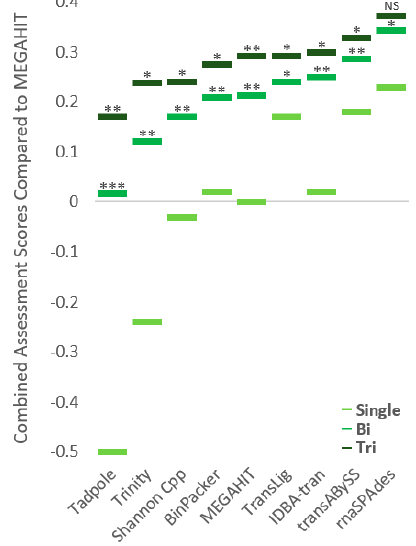
Figure 2. Single-, bi-, and tri-assembly assessment score averages. Average assessment scores from single-, bi-, and tri-assembly runs compared to MEGAHIT single-assembly as a baseline score (0). Scores lower than 0 underperformed when compared to MEGAHIT single-assembly, whereas, scores higher than 0 overperformed. Average assessment scores calculated by the average of HISAT2 overall alignment, BUSCO complete score, and TransRate n50 and n90 metrics averaged across all files processed. Assemblers utilized are included in the x-axis to denote both their average scores for single assembly and their average scores as part of a pair of two or three. Two tailed paired T-tests were conducted between single-assembly and bi-assembly, and between bi-assembly and tri-assembly. P-values are noted between single- and bi-assembly combinations and between bi- and tri-assembly combinations. All comparisons conform to p < 0.05 except for no-significance noted between bi- and tri-assembly associated with rnaSPAdes. *** is p < 0.00001, ** is p < 0.001, * is p < 0.05, and NS (No Significance) is p > 0.5. P-values are under FDR (False Discovery Rate) correc- tion.